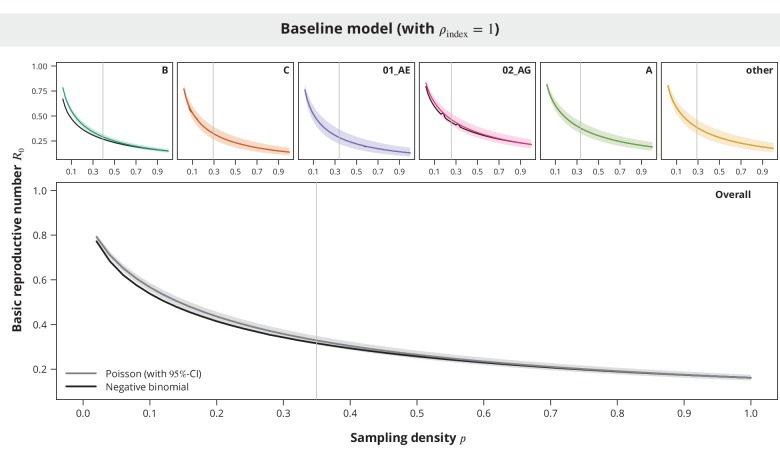
Comparison between the Poisson and the negative binomial offspring distribution baseline model R0 estimates.The dark gray and colored lines show the estimates from the model with Poisson offspring distribution, while the black lines correspond to the negative binomial distribution. The index case relative transmission potential parameter ρindex was fixed to 1 and the sampling density (x-axis) varied. In the overall analysis the sampling density was the same for all transmission chains regardless of their subtype. The vertical gray lines depict the sampling densities used for each subtype in our study (above panels) and the mean sampling density in the overall analysis (bottom panel).